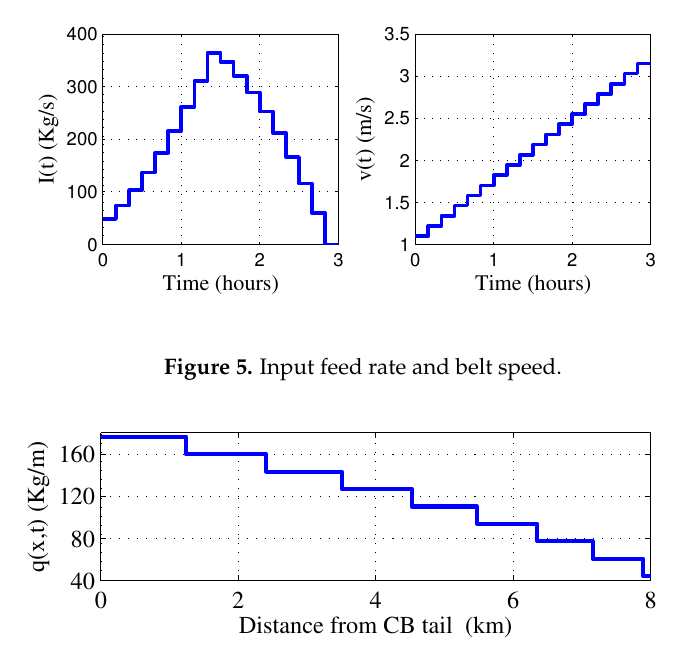
Figure 6. First-in-first-out (FIFO) queue model of the actual q ( x , t ) on the belt after 1.5